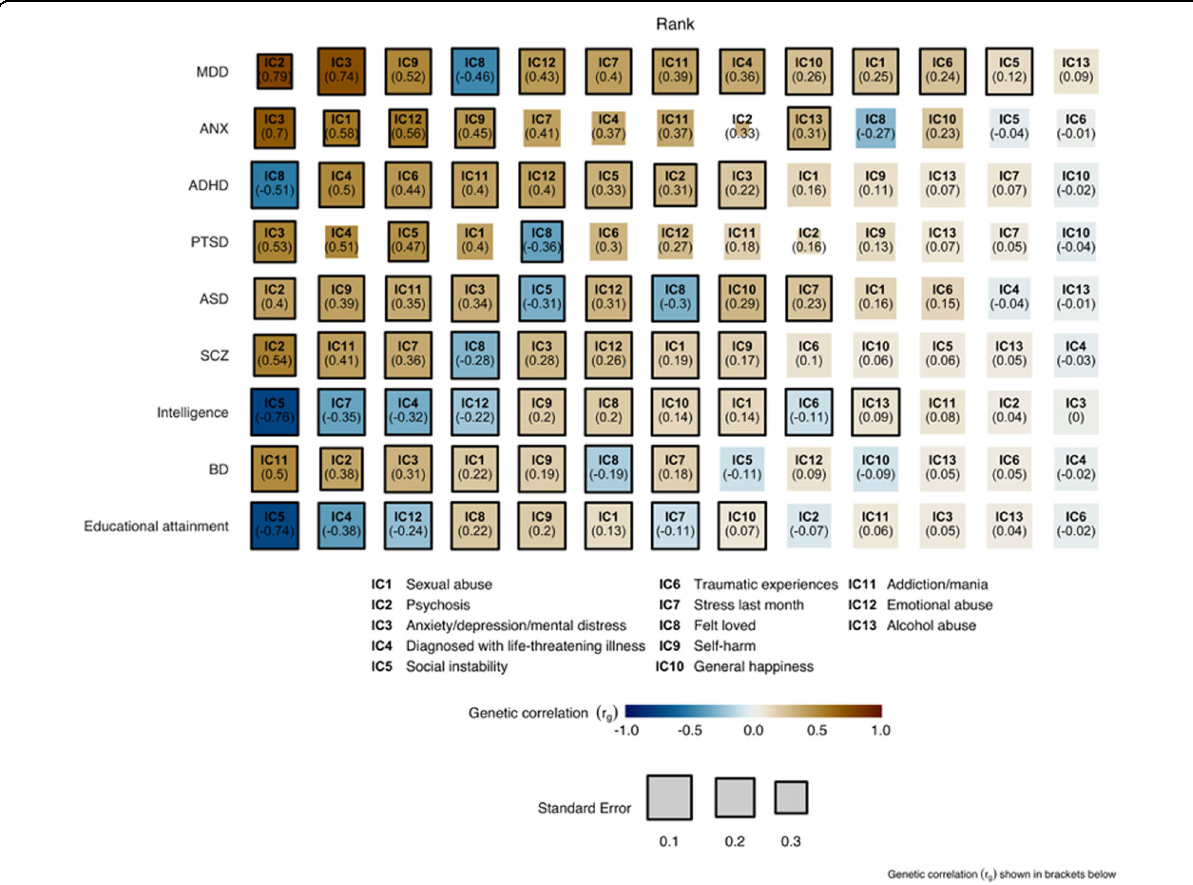
Fig. 3 Genetic correlation between the independent components and disorders and cognitive traits. For each disorder, the associations with ICs are sorted by decreasing absolute genetic correlation such that the most leftward box re fl ects the strongest association between a given disorder and the 13 ICs. Numbers in brackets under each IC label denote the genetic correlation ( r g ). Size of the boxes re fl ect the standard error. Signi fi cant correlations ( p < FDR) are indicated with a black